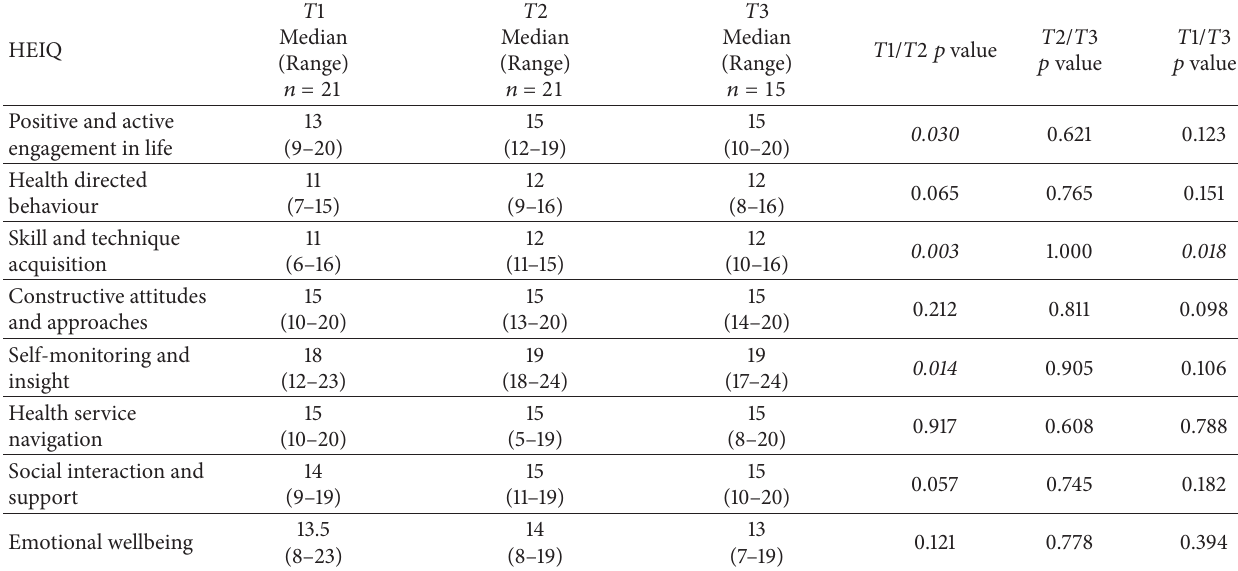
Table 4: HEIQ T 1, T 2, and T 3